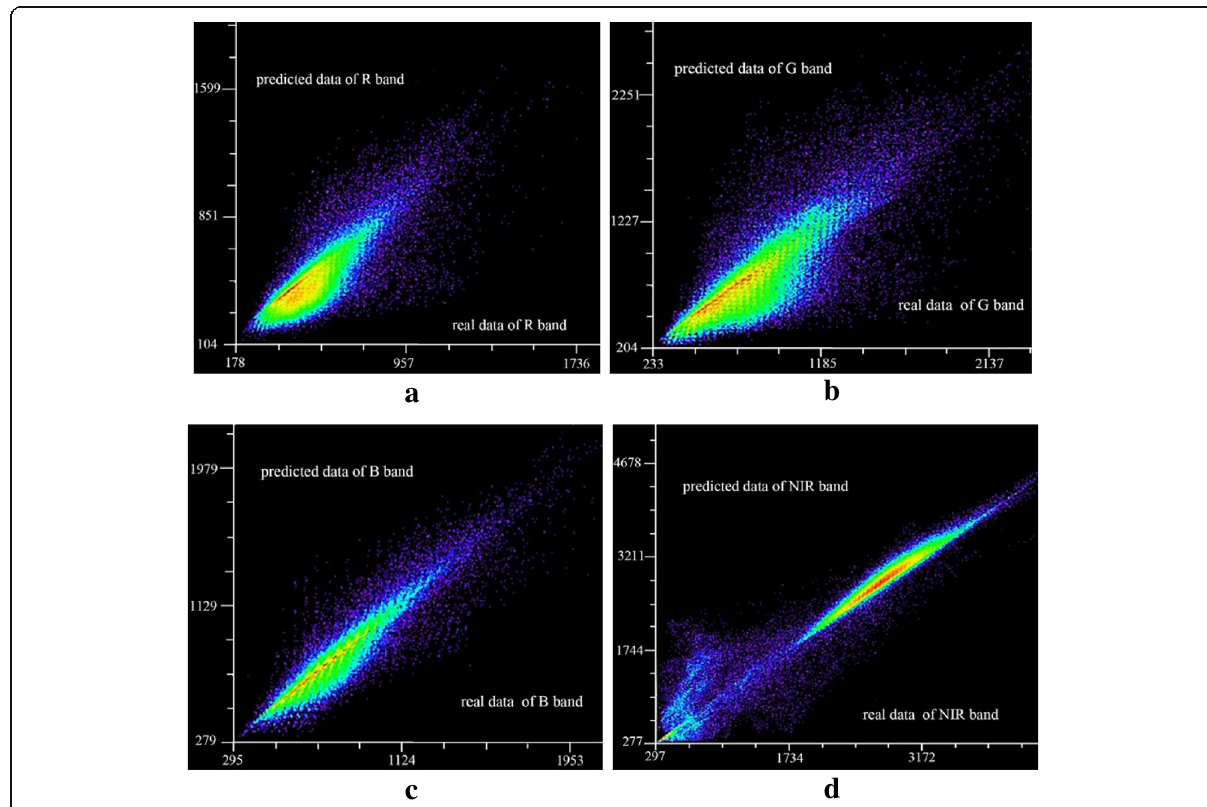
Fig. 2 The correlation analysis of fusion forecast reflectance data with TM. a Correlation between real data and predicted data of R band. b Correlation between real data and predicted data of G band. c Correlation between real data and predicted data of B band. d Correlation between real data and predicted data of NIR band